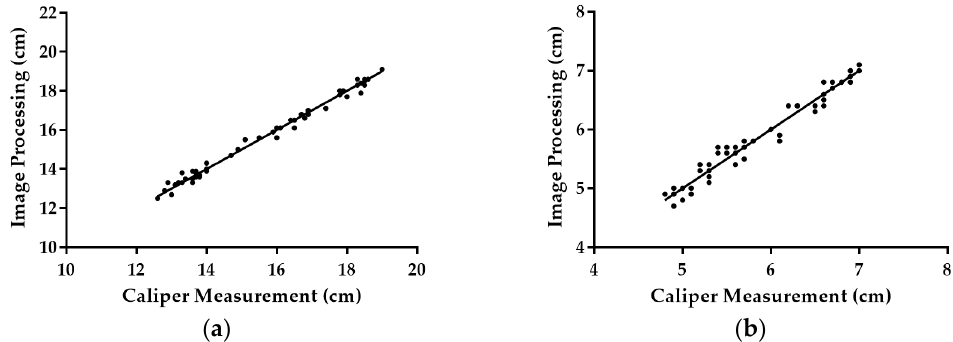
Figure 11. Dimension measurement of mango using caliper and image processing. ( a ) Plot for length measurement; ( b ) Plot for height measurement.